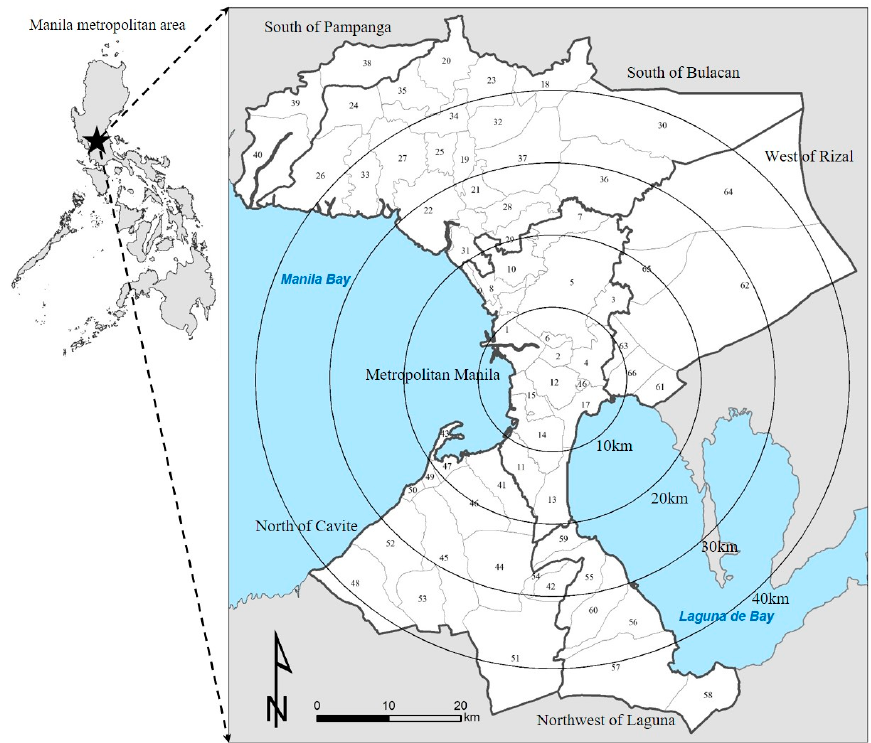
Figure 3. Administrative division in Manila metropolitan area. Data source: GADM. (Note: Circle center shows the Makati CBD. ID corresponds to place name (cf. Table A1 in Appendix A).). Table 1. Sample description (estimated variables) of person-trip survey data based on different human properties (unit: one thousand persons). Data source: CSIS, author’s calculations